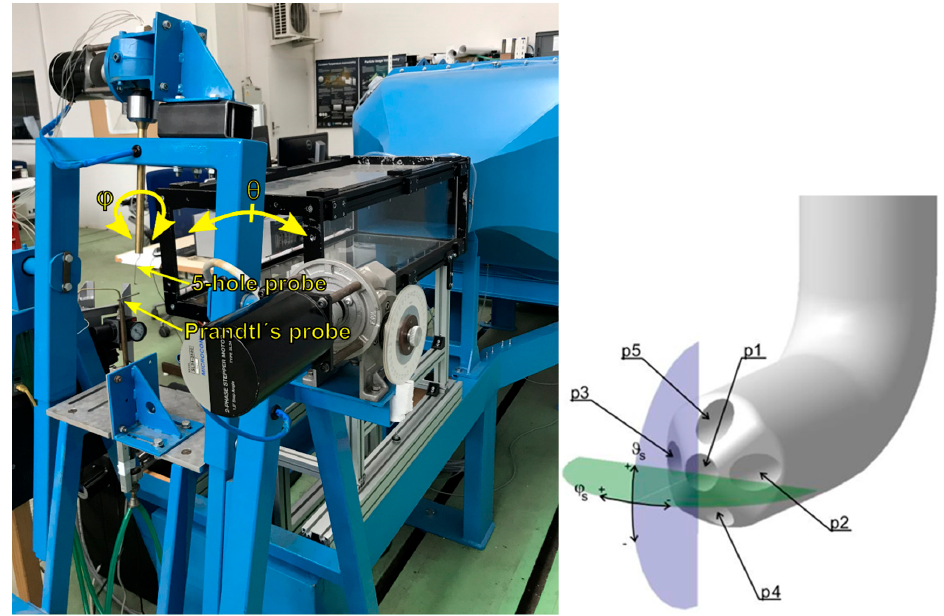
Figure 3. Pneumatic probe calibration test rig ( left ); five-hole probe detail ( right ). The calibration was realized by setting a certain angle θ , at which the pressures are measured for different values of the angle φ in the range φ = ( − 20°; 20°). Subsequently, the turning device is shifted by an angle θ and the pressures are measured again for the entire range of angles φ . The range of angles θ was also θ = ( − 20°; 20°). A Prandtl probe serves as a “standard” for determining static and total pressure. Calibration coefficients (two pressure, two angular) were calculated from obtained data [11].